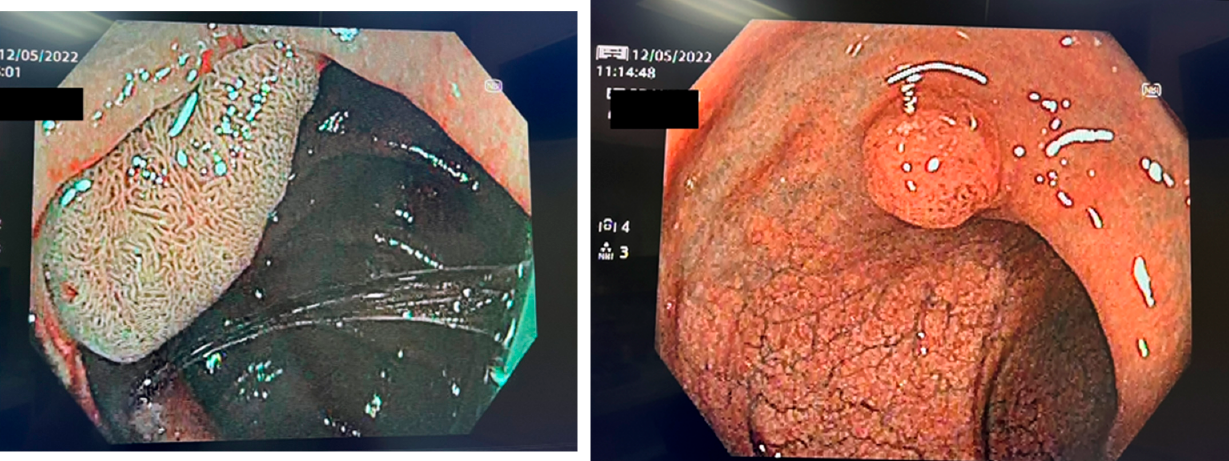
Figure 1. NBI visualization of colon